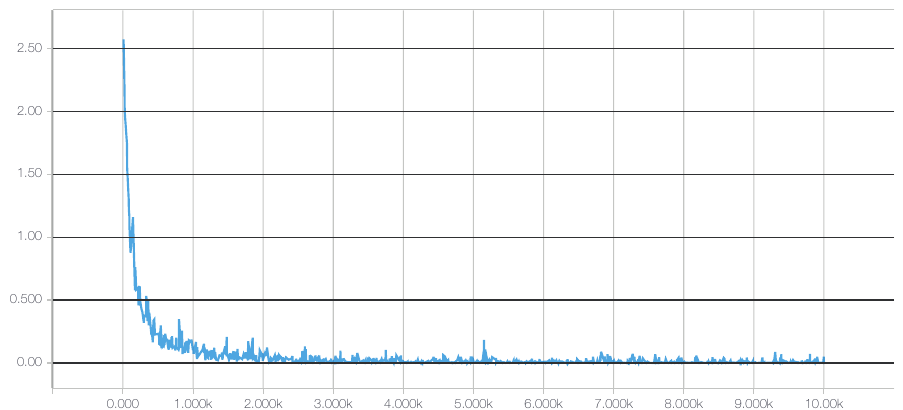
Figure 4. Evolution of the logistic regression loss function along iterations of the deep neural network training process, generated with